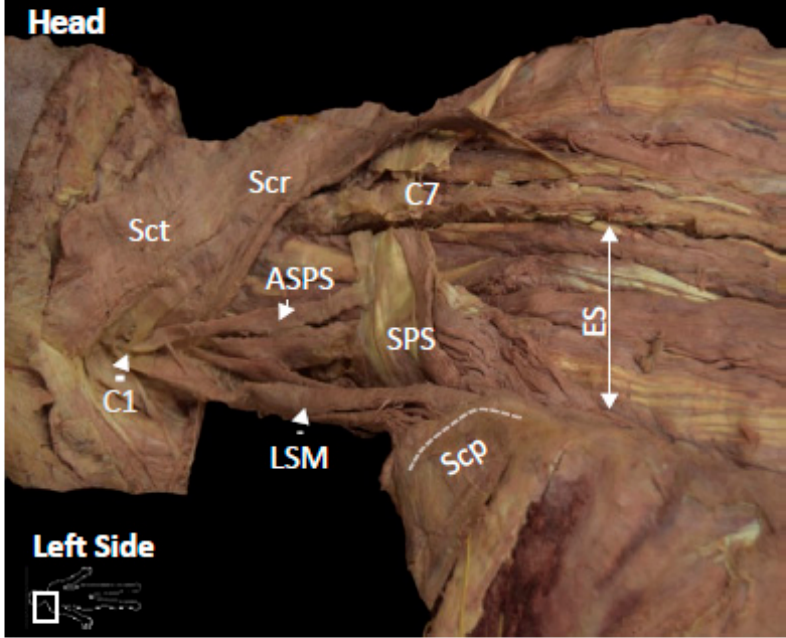
Figure 1. Overview of the Posterior Intermediate/Deep Neck. Accessory Serratus Posterior Superior (ASPS) Muscle; Atlas transverse process (C1); Spinous process of cervical vertebra 7 (C7); Erector Spinae (ES) Muscles; Levator Scapulae Muscle (LSM); Scapula (Scp); Serratus Posterior Superior (SPS ) Muscle; Splenius capitis (Sct ) Muscle; Splenius cervicis (Scr ) Muscle.